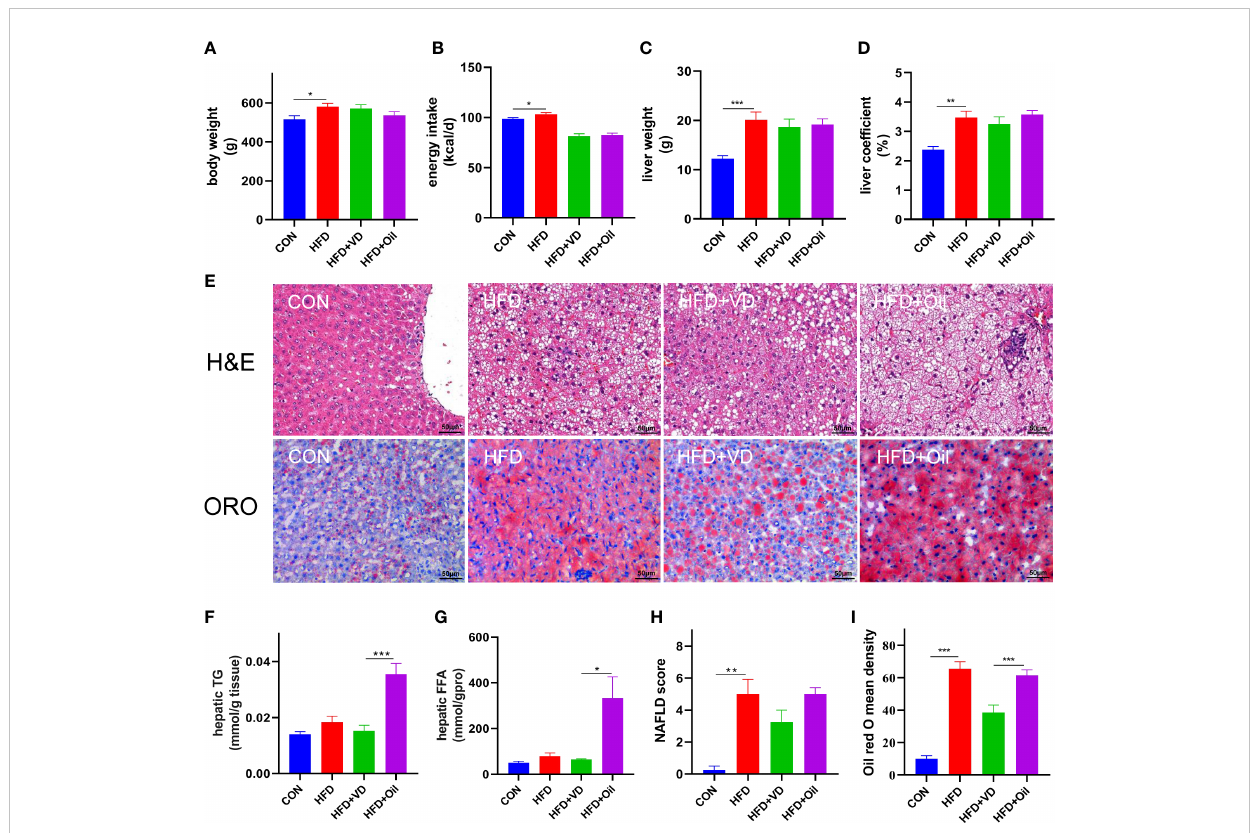
FIGURE 1 Vitamin D treatment ameliorate hepatic steatosis in NAFLD rats. (A) body weight, (B) energy intake, (C) liver weight, (D) liver coef fi cient, (E) H&E staining of liver tissues (400 × magni fi cation) and Oil red O staining of liver tissue (400 × magni fi cation). Four rats in each group were captured three views for evaluation of steatosis, lobular in fl ammation and balloon degeneration. Both scores are examined by an experienced pathologist who was unaware of the study. (F) Quanti fi cation of hepatic TG and (G) FFA in liver tissue. (H) NAFLD score and (I) Oil red O density of liver. Data were shown as the mean ± SEM. (n=8); *P < 0.05, **P < 0.01, ***P <